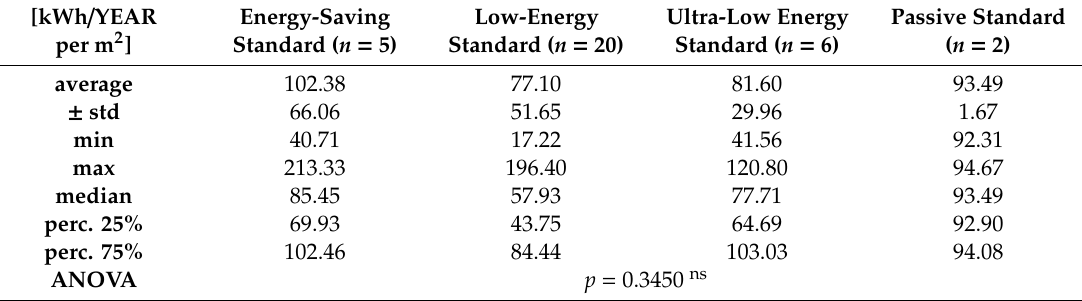
Table 4. Annual energy demand for heating categorized according to energy standards calculated per m 2 of useful floor area of the analyzed panel wood constructions.